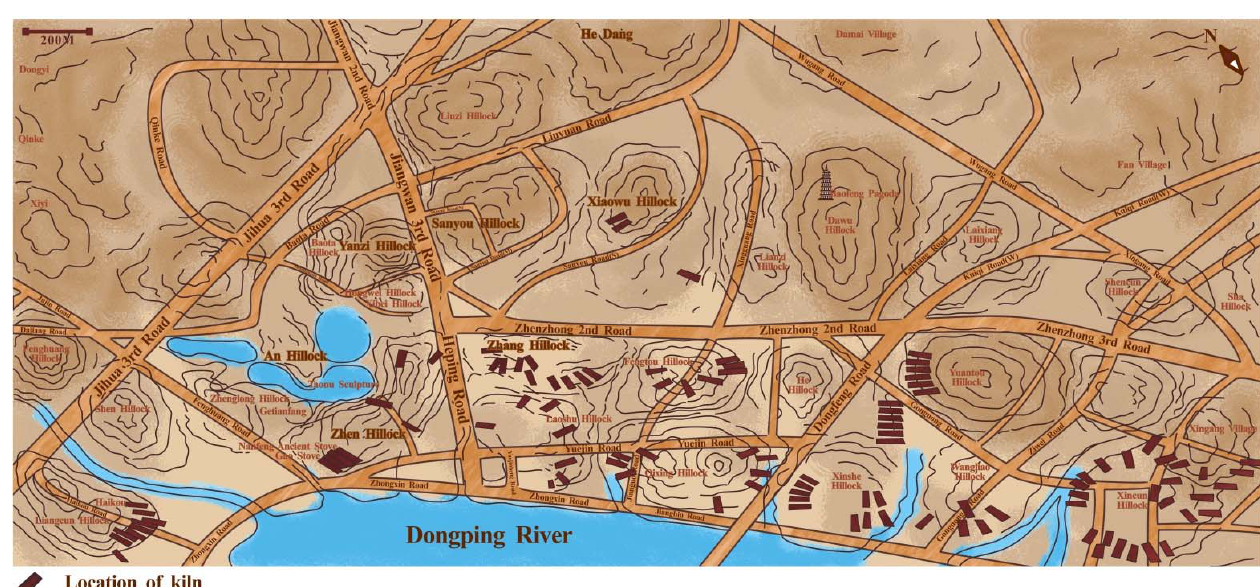
Figure 2. The location of ancient Shiwan kilns and hillocks on the modern map.